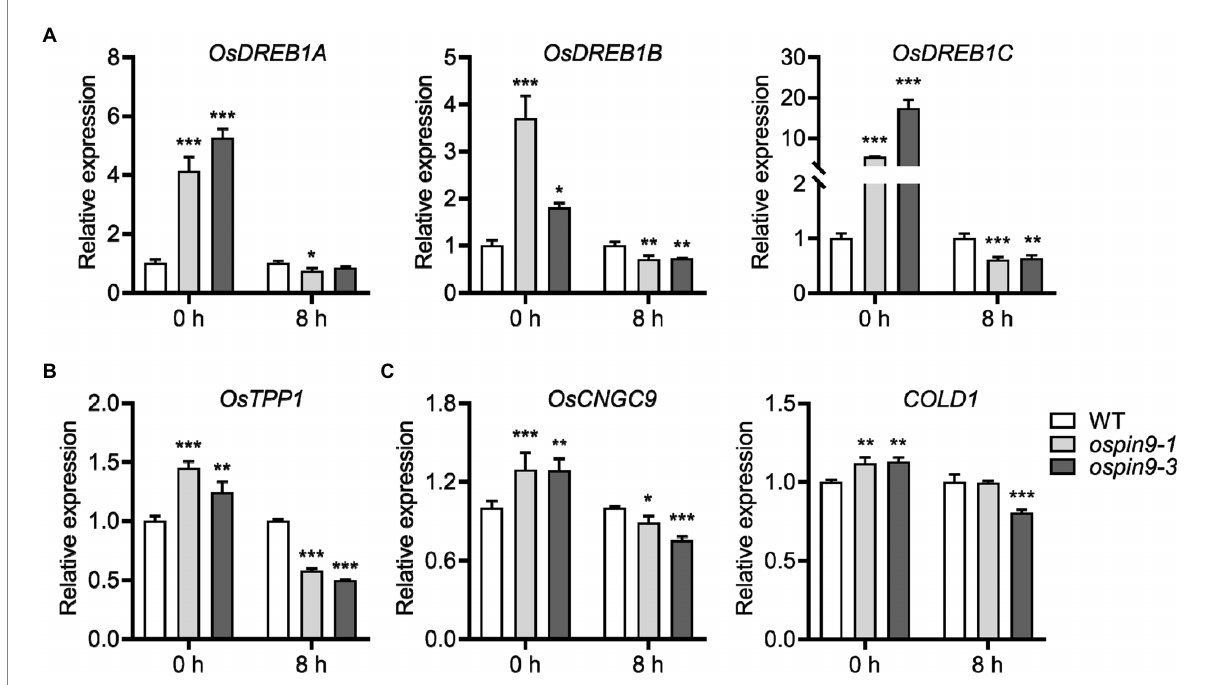
FIGURE 6 OsDREB1 genes, OsTPP1, and Ca 2+ signaling genes expression under normal and chilling conditions in WT and ospin9 mutants. (A) OsDREB1s gene expression analysis. (B) OsTPP1 expression analysis. (C) Ca 2+ signaling genes expression analysis. Values were means ± standard deviation (SD; n = 3). Data were analyzed by ANOVA and Tukey’s tests at p < 0.05 significant